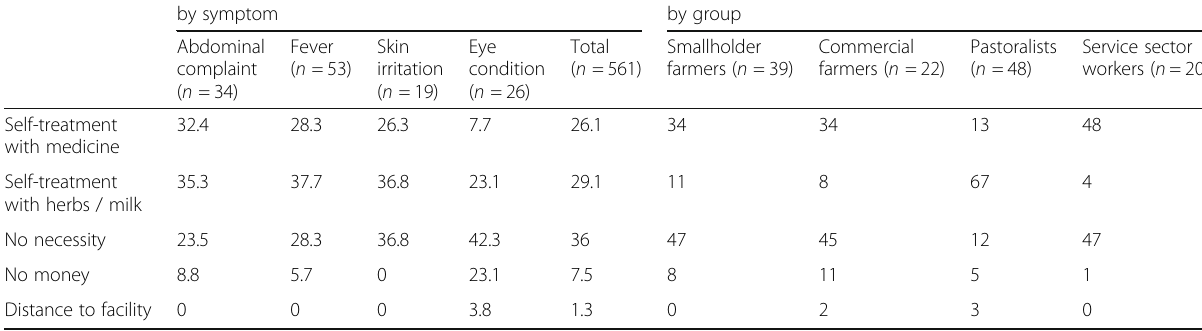
Table 6 Reasons for not seeking healthcare, stratified by symptoms and groups [%] by symptom by